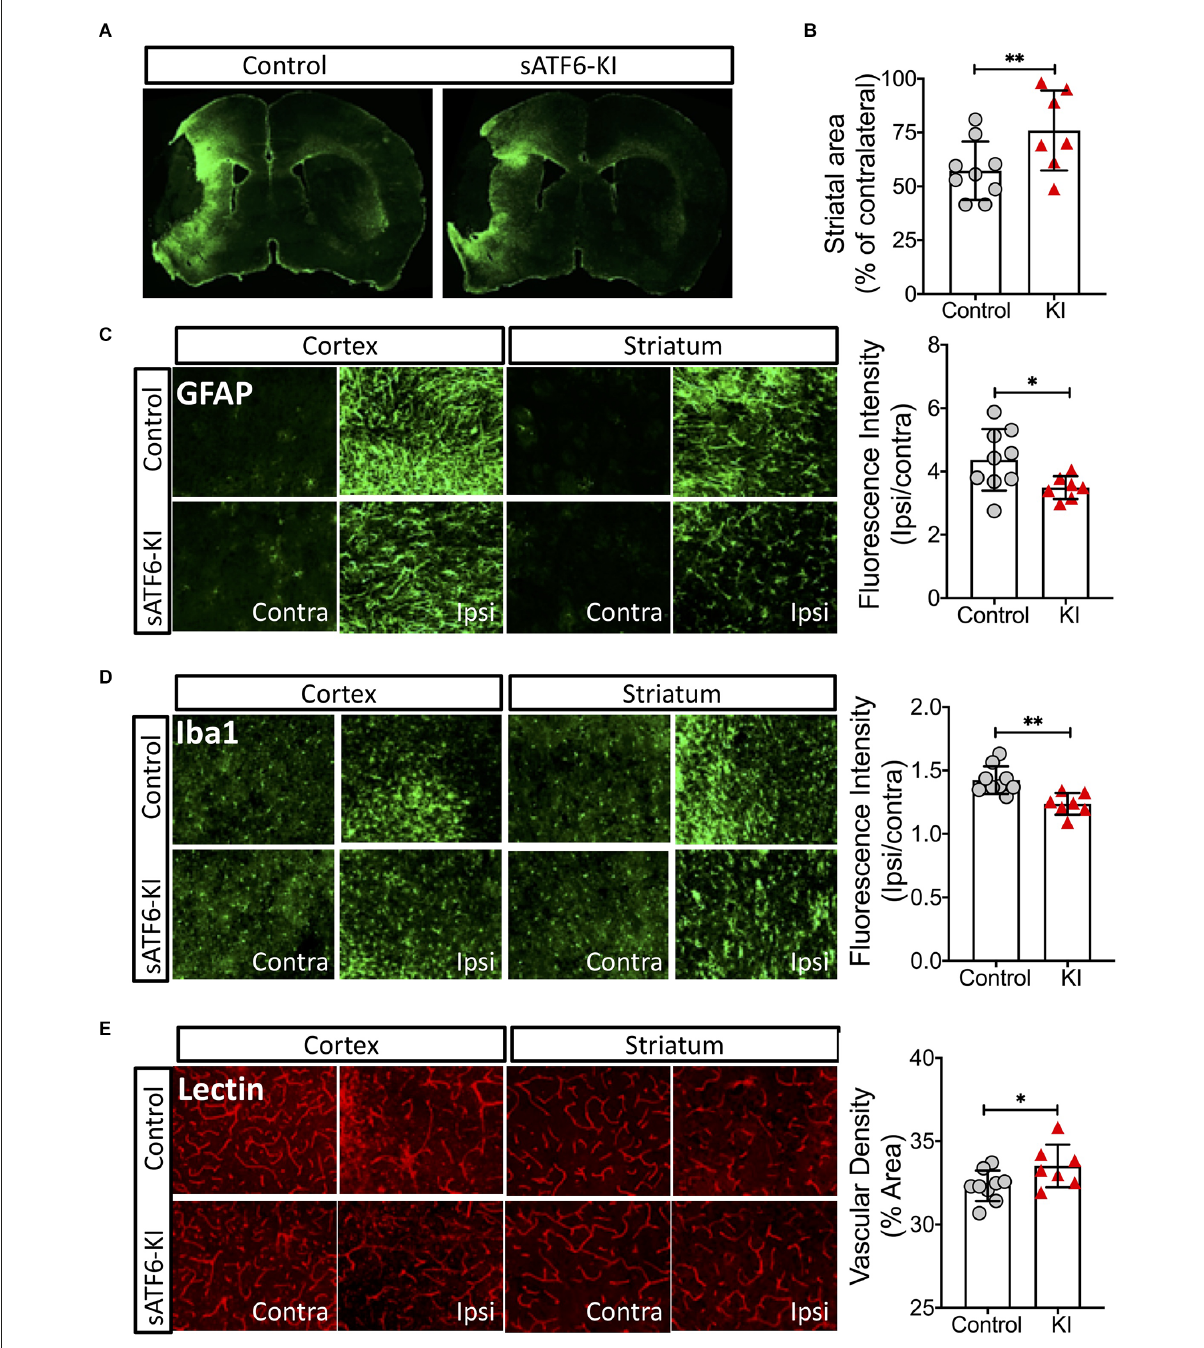
FIGURE4 Effects of neuronal ATF6 activation on the brain after pMCAO. The mice were from the same experiment as in Figure 3 . On day 16 after stroke, all mice received lectin injection before euthanasia. Brain sections were used for analyses. (A–C) Brain sections were stained with GFAP (an astrocyte marker). Representative GFAP-stained coronal brain sections (A) . Striatal volumes (B) . Astrogliosis (C) . Microglia activation was evaluated by Iba-1 staining (D) . Vascular density was evaluated by lectin signal (E) . Data are presented as mean ± SD. ∗ p < 0.05; ∗∗ p < 0.01. Contra, Contralateral; Ipsi, Ipsilateral; KI,